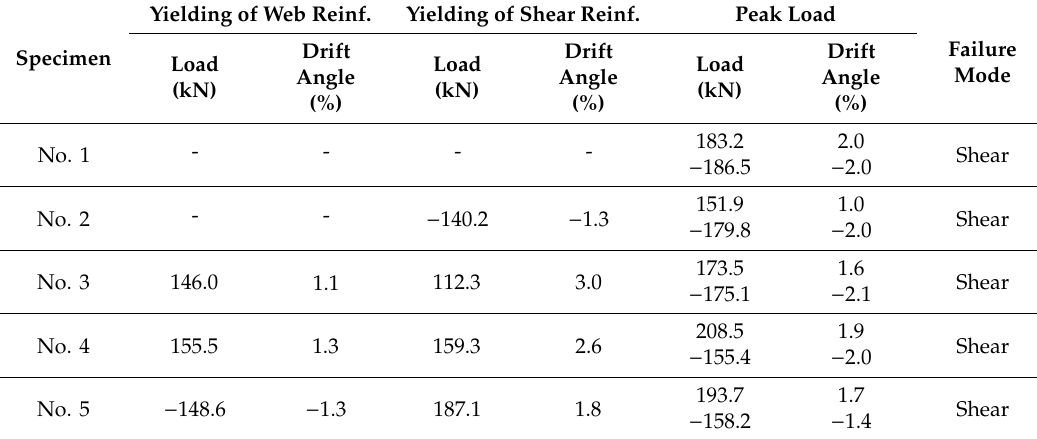
Table 4. Summary of experimental